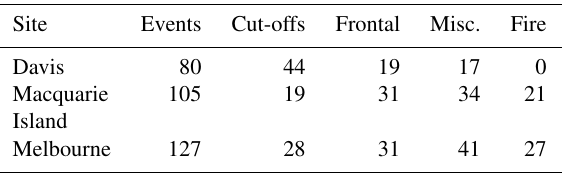
Table 2. Total number of ozonesonde detected STT events, along with the number of events in each category (see